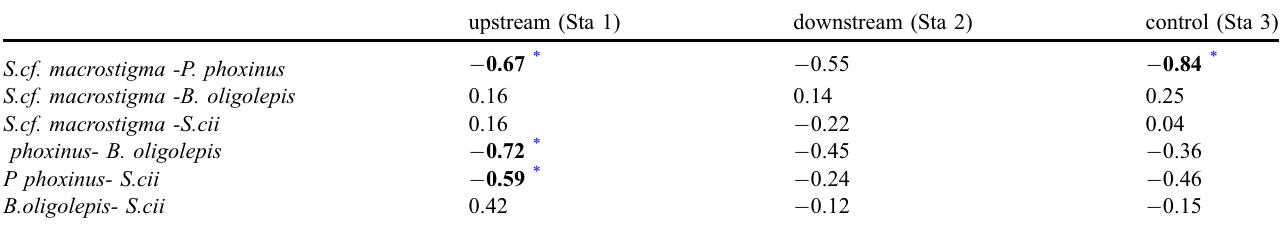
Table 1. Correlation test results (Spearman's rho) for monthly relative species abundances at three sampling stations on Kocabas Stream near a fi sh farm ( n =11 months).